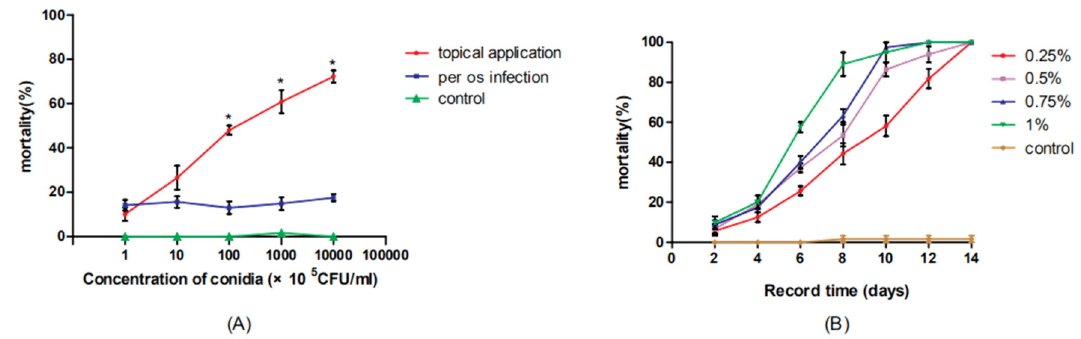
Figure 1. ( A ) The cumulative mortality of B. germanica infected with M. anisopliae conidia at different concentrations with per os infection and topical application at 14 days postinoculation under laboratory conditions; * indicates that the mortality with topical dorsal infection significantly differs ( p < 0.05) from that with per os infection. ( B ) The cumulative mortality of B. germanica fed with hydramethylnon at different concentrations in baits at 14 days postinoculation under laboratory conditions.